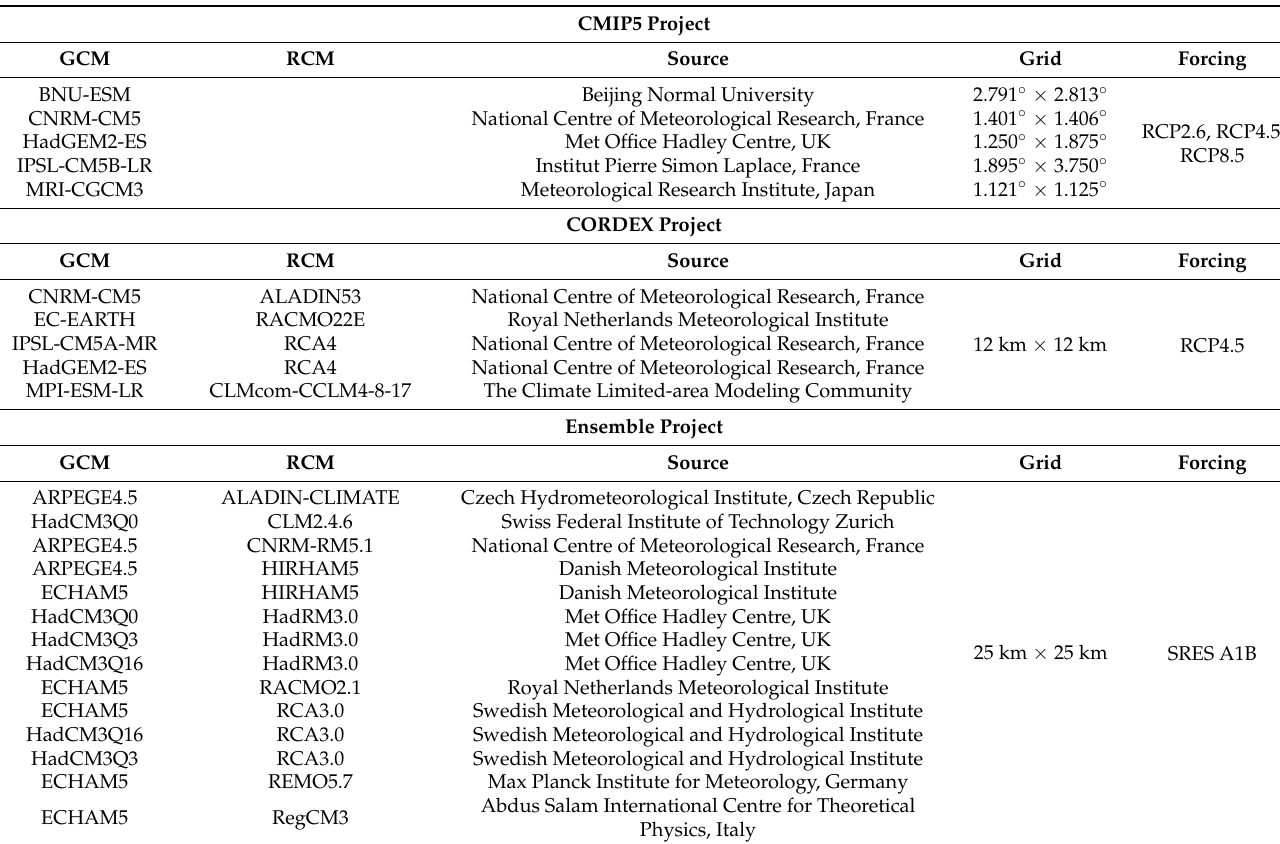
Table 1. Used climate